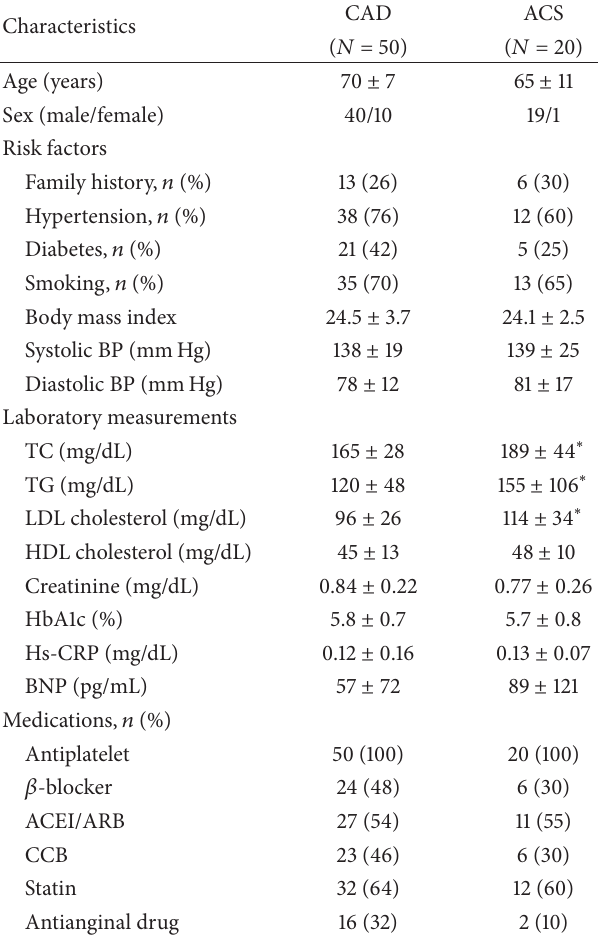
Table 2: Clinical characteristics of